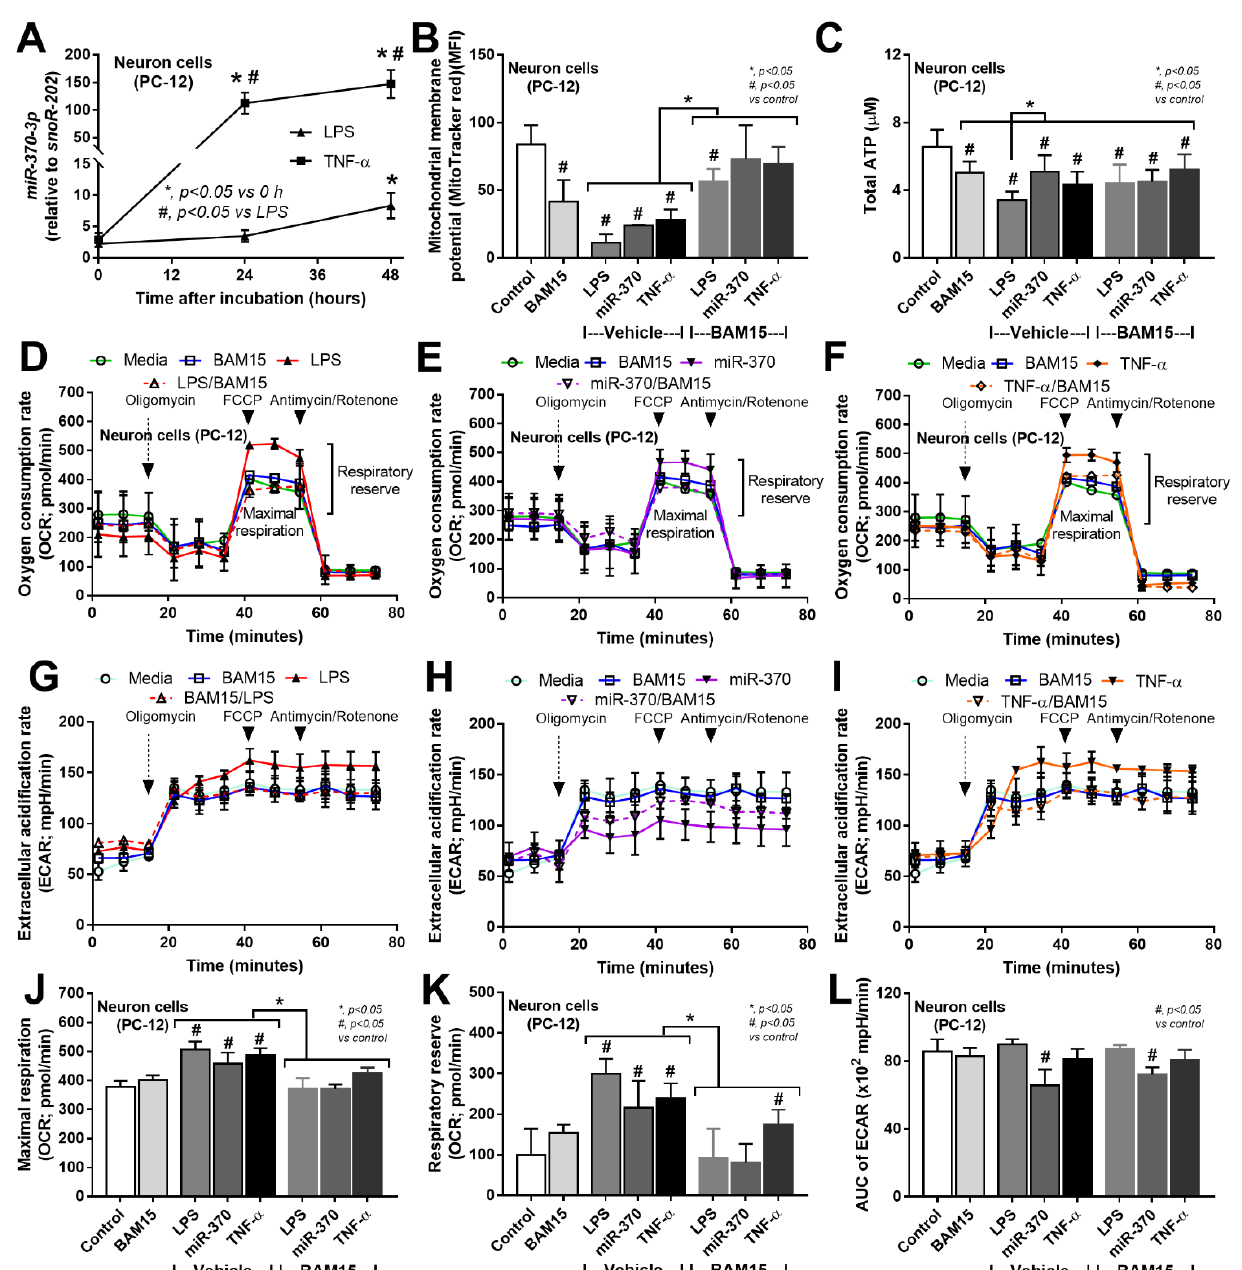
Figure 7. The expression of miR370-3p in neuron cells (PC-12 cell line) after stimulation with lipopolysaccharide (LPS) and TNF- α ( A ) and characteristics of PC-12 cells after 48 h stimulation by LPS, miR370-3p transfection, or TNF- α with or without BAM15, in comparison with control media (media) or BAM15 alone, as evaluated by mitochondrial membrane potential ( B ), total cell ATP ( C ), cell energy status through mitochondria (oxygen consumption rate; OCR) and glycolysis (extracellular acidification rate; ECAR) with several parameters (maximal respiration, respiratory reserve, area under the curve (AUC) of ECAR) ( D – L ) are also demonstrated. #, p < 0.05 vs. control; *, p < 0.05 vs. the indicated groups. The statistical analysis was determined by repeated measure ANOVA (time-point data) and ANOVA with Tukey’s method. #, p < 0.05 vs. control; independent triplicate experiments were performed. Notably, media and BAM15 control groups of miR370-3p transfection were also transfected by miR370-3p mimic (miR-negative control). MFI, mean fluorescent intensity.